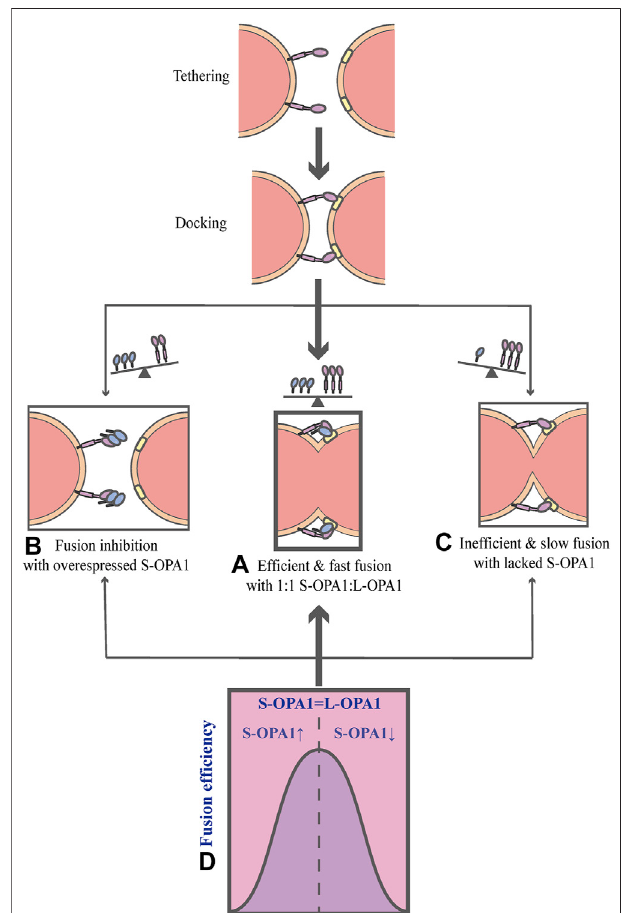
FIGURE 3 | Schematic diagrams of OPA1-dependent IMM fusion. The process of mitochondrial IMM fusion includes several sequential steps: tethering,membranedockingandfusing. (A) Itexhibitsef fi cientandfastfusion at equimolar levels of S-OPA1 and L-OPA1. (B) When S-OPA1 is overexpressed, the activity of fusion is inhibited and the fusion ef fi ciency is reduced. (C) When the S-OPA1 level is lower than L-OPA1, slow and inef fi cientfusionoccurs. (D) TheactivityoftheIMMfusionpeaksataratioof1: 1S-OPA1: